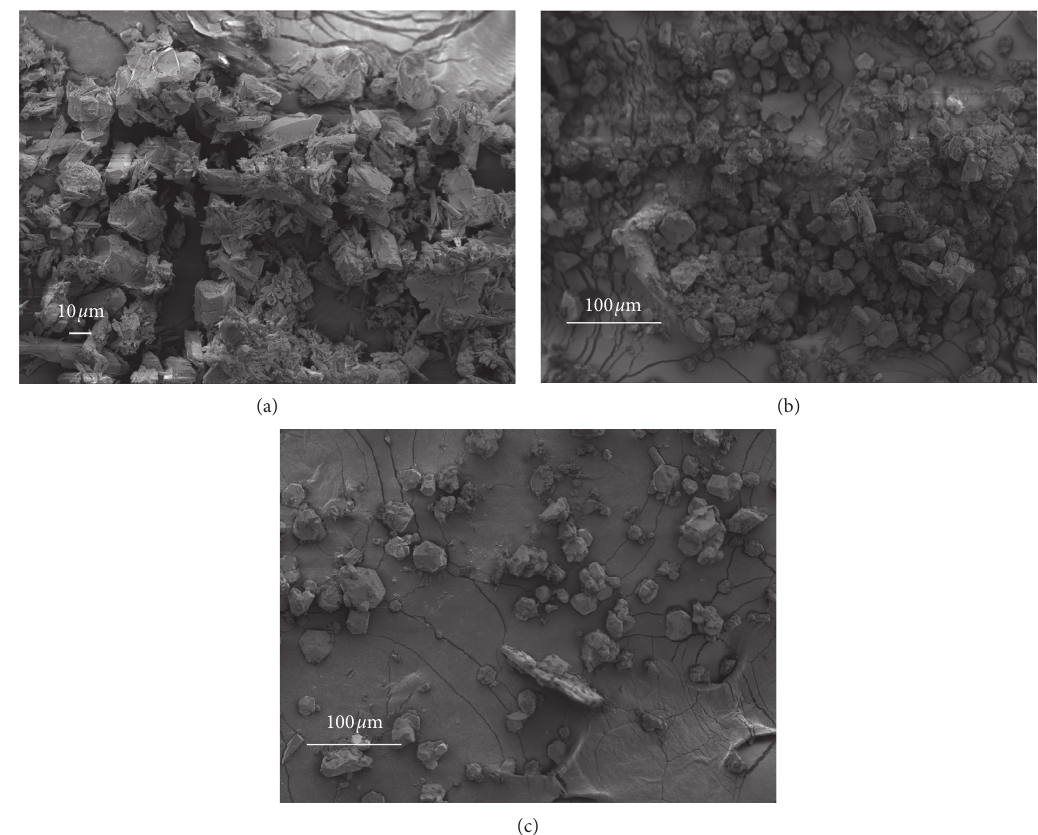
Figure 10: Crystal morphology of the solid phase obtained by succinic acid (doped with (a) 0.01%; (b) 0.02%; (c) 0.03%) for 1.5 h.